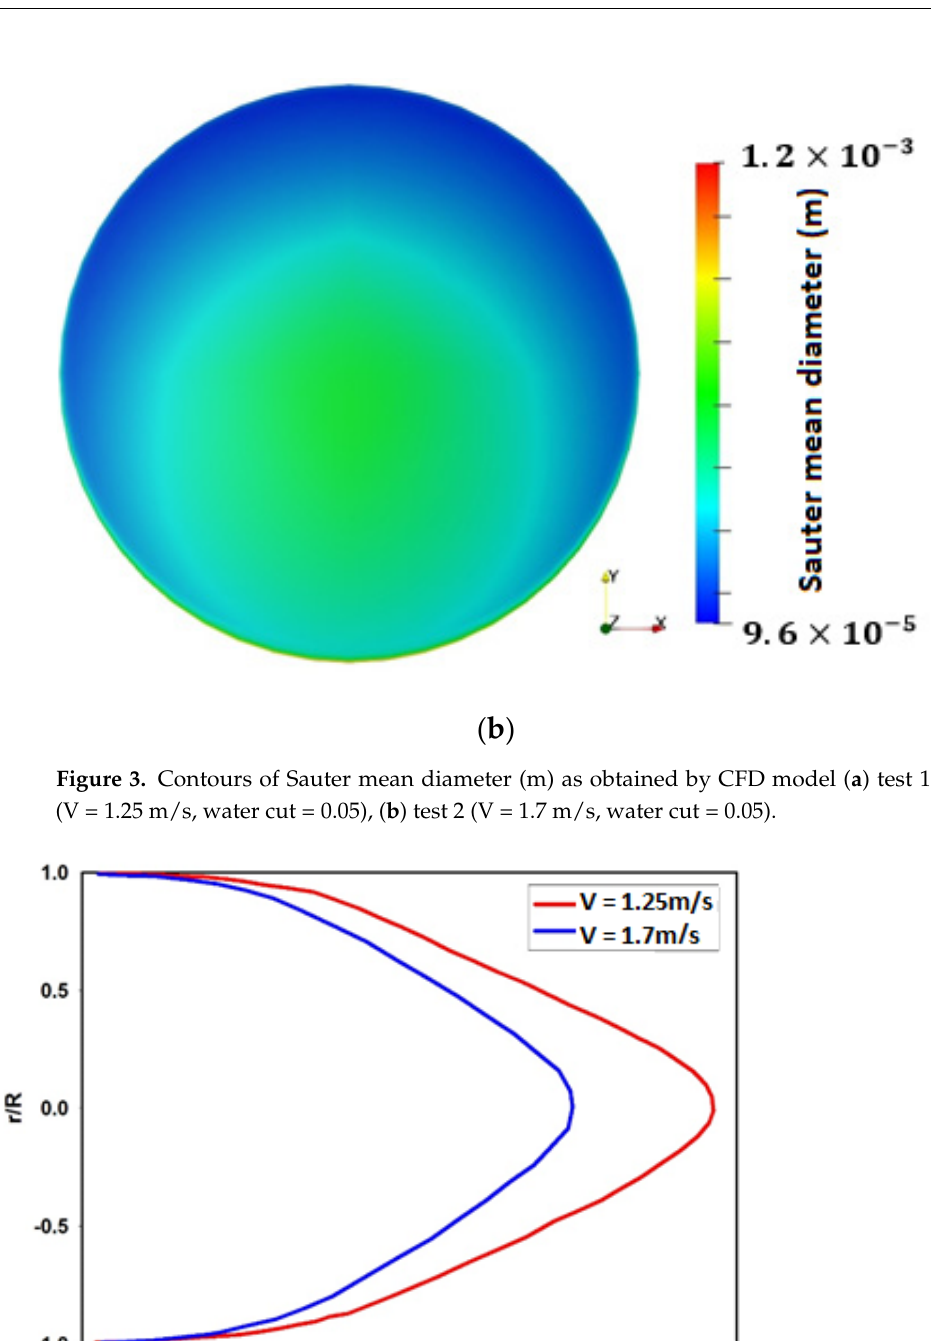
Figure 4. The magnitude of the Kolomogorov length scale across the pipe